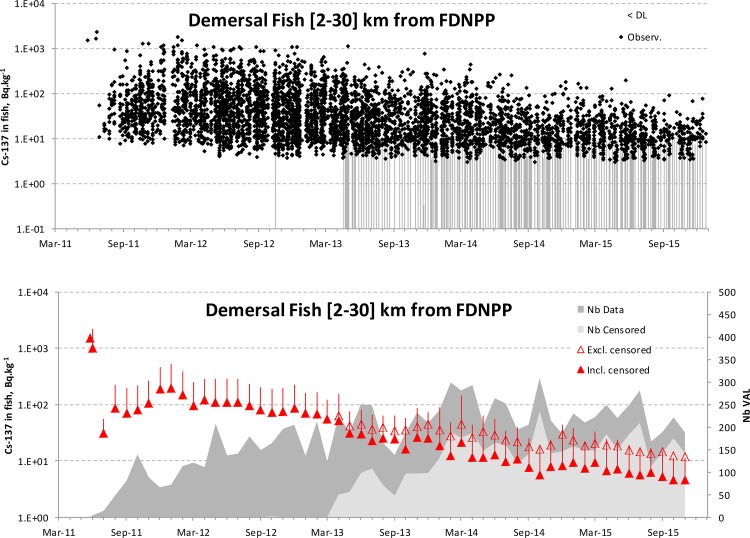
Upper panel: Raw data of Cs-137 values (left Y-axis in log scale) in demersal fish from the near field ([2-30] km from FDNPP); black dots: values above the LoD; vertical bars: censored values (<LoD). Lower panel: Open triangle: monthly averaged levels in fish computed without the censored values; solid triangle and vertical bars: monthly averages + SD computed with the censored values. Dark grey and light grey areas (right Y-axis): the total number of values and the number of censored values, respectively.